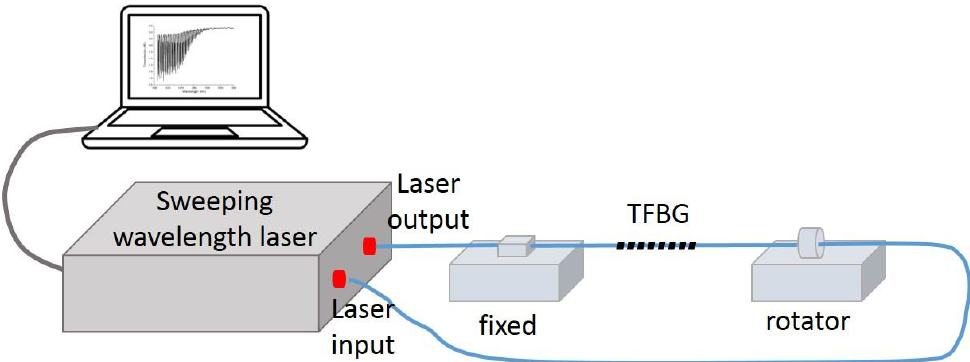
Figure 7. Schematic setup of torsional detection.